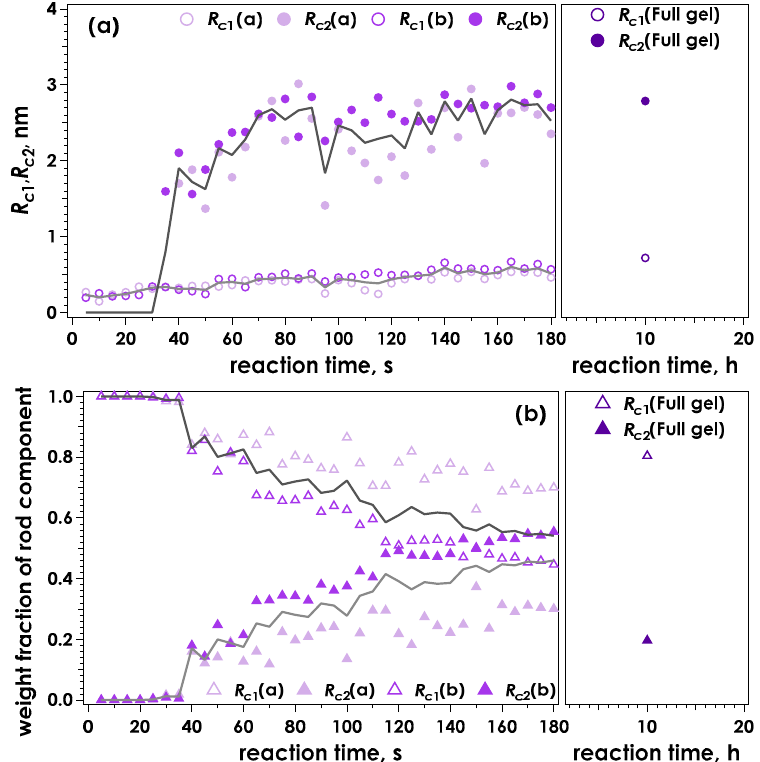
Figure 8. Time course for the calculated radii of the two rod components, R c1 and R c2 ( a ) and the corresponding weight fractions of the two components ( b ) determined by evaluation of the data presented in Figure 7 using a broken rod model. The solid lines indicate the averaged values for the two measurements.